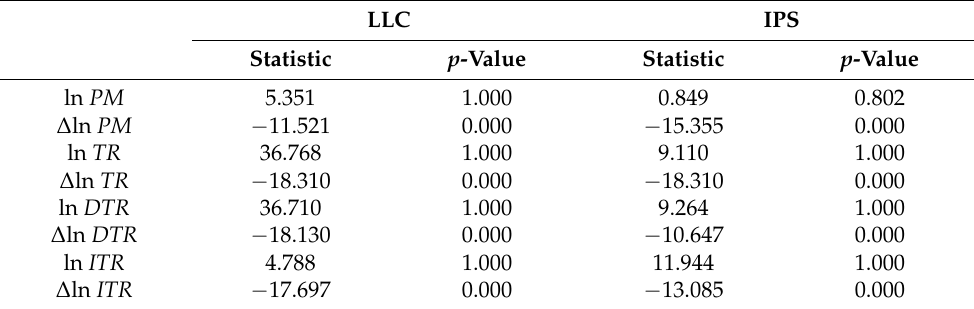
Table 2. The results of stationarity test.